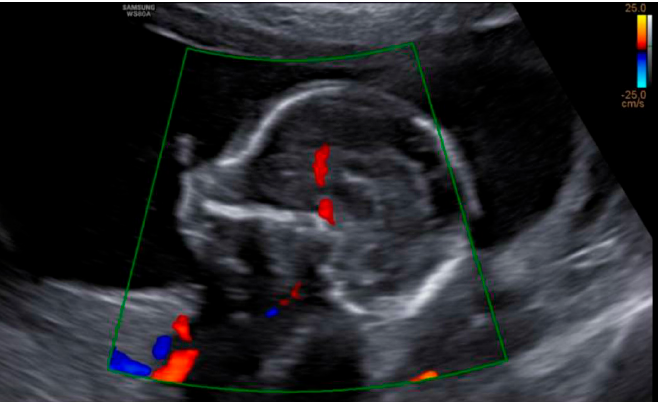
Figure 3. In sagittal section, the corpus callosum is not present. Both findings are consistent with total ACC.